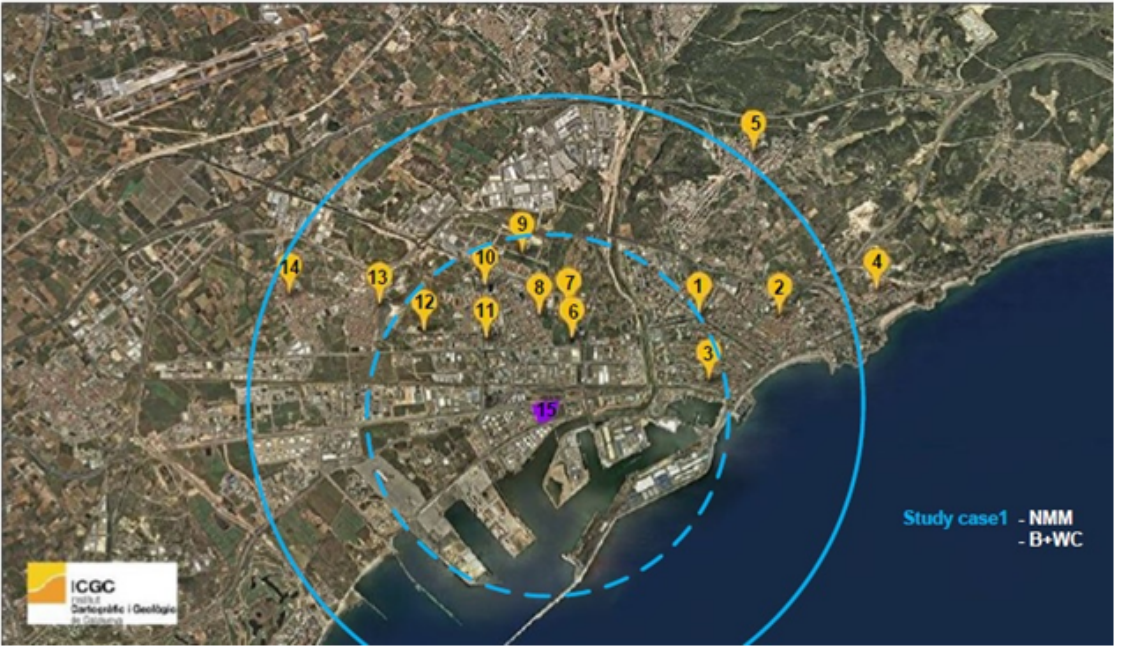
Figure 1. Representation of the distances of affectation of the possible accident according to the designs used (none or bund and water